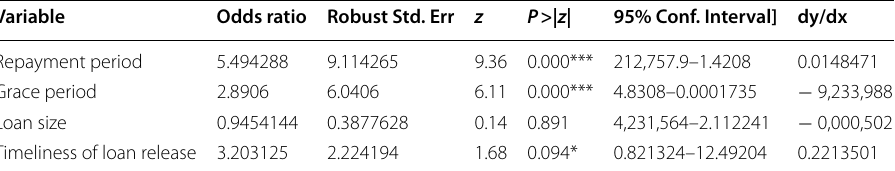
Table 2 Summary result of econometric model